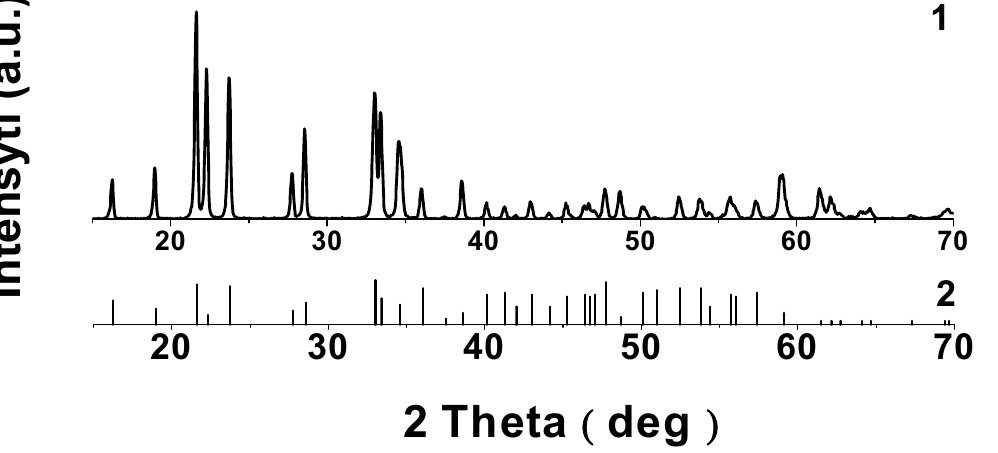
Figure 1. ( 1 ) XRD pattern of Li 3 . 8 Ge 0 . 9 S 0 . 1 O 4 and ( 2 ) line diagrams of powder pattern for Li 3 . 6 Ge 0 . 8 S 0 . 2 O 4 (PDF2, № 44-0337).